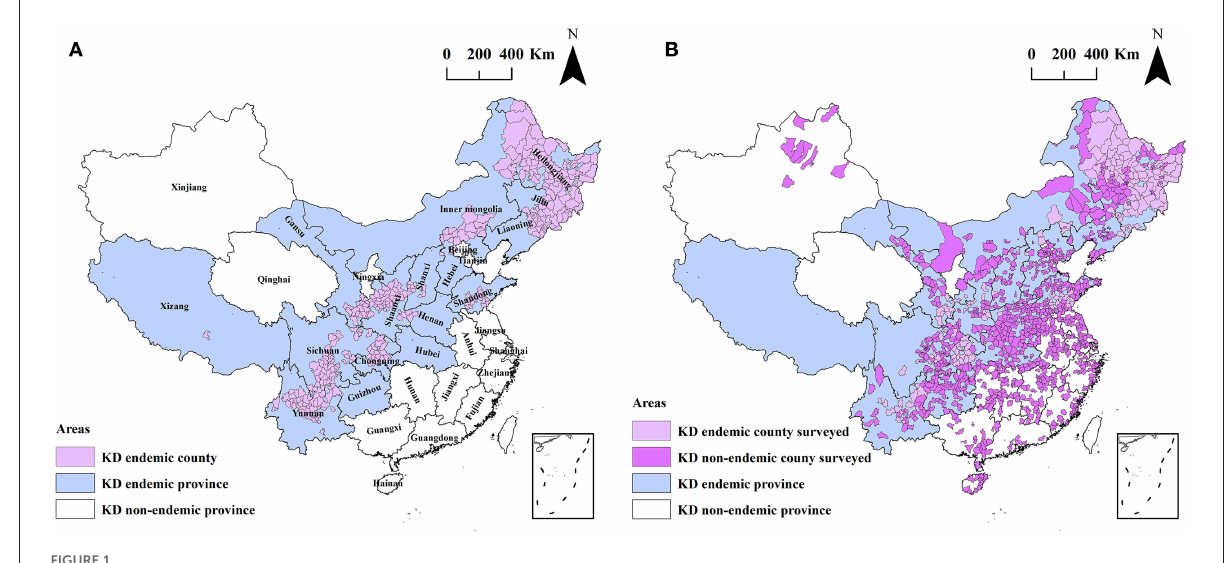
FIGURE1 The spatial distribution of the KD endemic regions (A) and the surveyed counties in this study (B) .